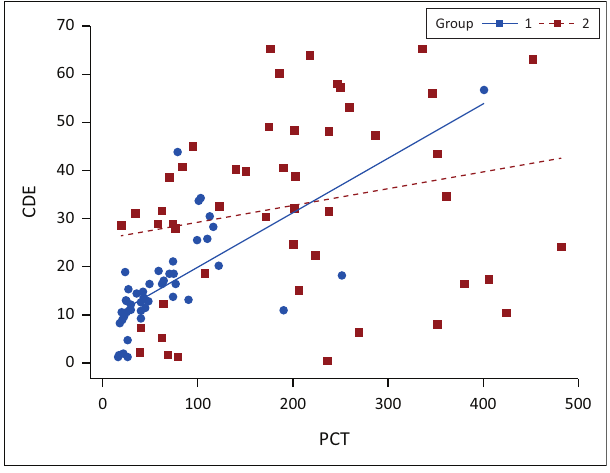
FIGURE 2: Fitted line plot between cumulative dissipated energy and difference in peripheral corneal thickness